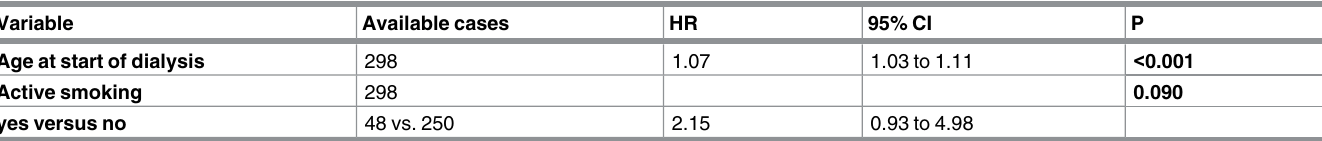
Table 5. Multivariable analysis for